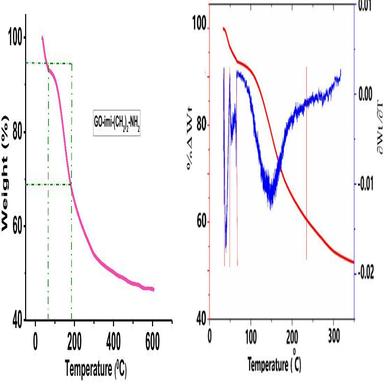
TGA diagram including weight loss and DTG (gradient weight altering (dW/dT)) against temperature for imi- (CH2)2-NH2.